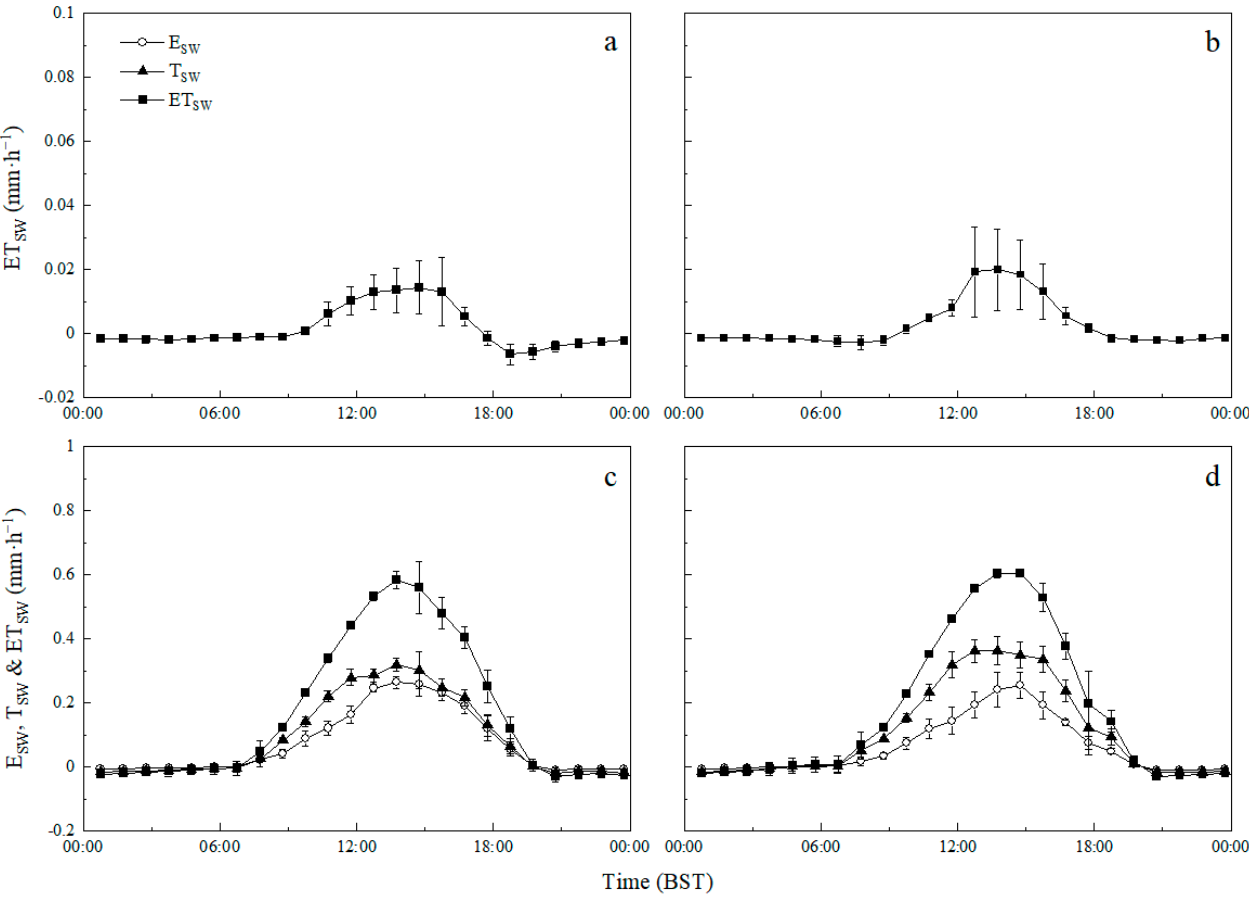
Figure 6. Diurnal variations of evaporation ( E SW ), transpiration ( T SW ), and evapotranspiration ( ET SW ) estimated by the S–W model on clear days in ( a ) Jan 2007, ( b ) Jan 2008, ( c ) Jul 2007, and ( d ) Jul 2008.